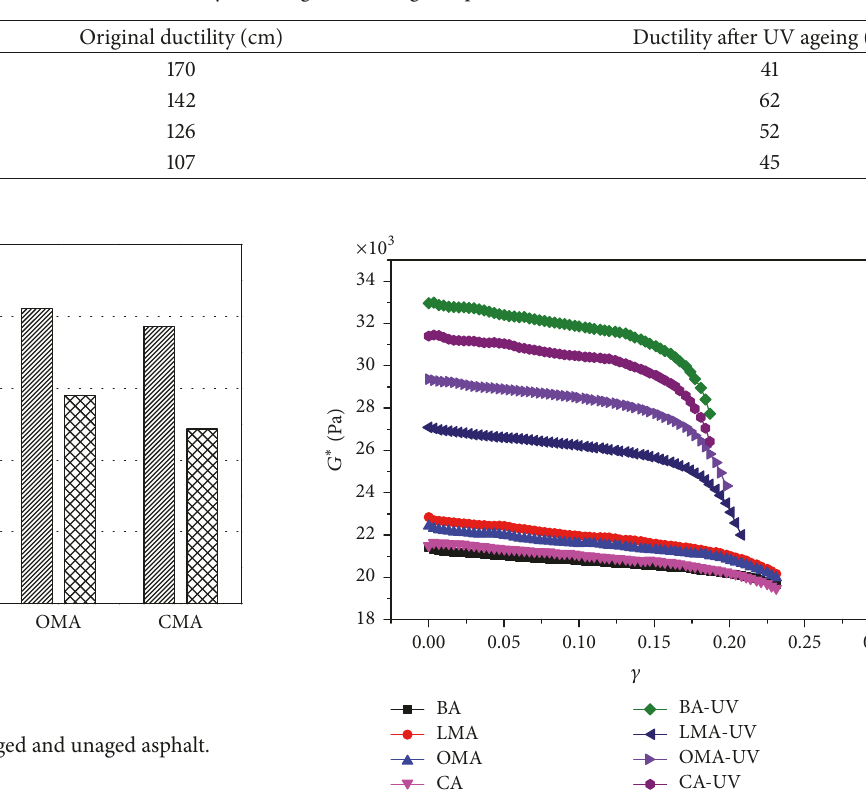
Table 2: Ductility of UV aged and unaged asphalt.